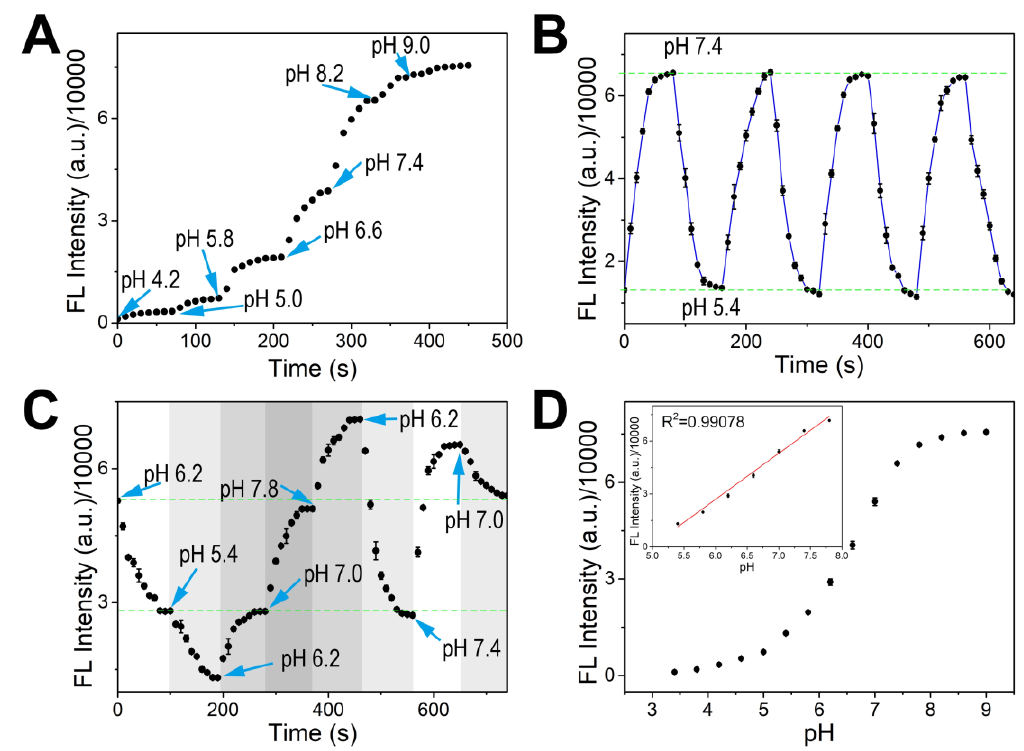
Figure 4. ( A ) Time response of pH detection from pH 3.4 to pH 9.0. The dots represent the fluorescence intensity recorded every 10 s, which is the same as ( B ) and ( C ). The moments when pH starts to change are pointed out with arrows, which is the same as ( C ). ( B ) Repeatability of the sensor for pH detection from pH 5.4 to pH 7.4. The green dashed lines represent reference fluorescence intensity corresponding to pH 7.4 (up) and pH 5.4 (down). ( C ) Time response of the sensor for continuous pH monitoring (pH 7.0 → 6.2 → 5.4 → 6.2 → 7 → 7.8 → 6.2 → 7.4 → 7.0). The green dashed lines represent reference fluorescence intensity corresponding to pH 6.2 (down) and pH 7.0 (up). ( D ) Detection curve of the sensor for pH. Inset: linear relation of fluorescence intensity to pH. Error bars in ( B – D ) are based on standard deviations (n = 3).